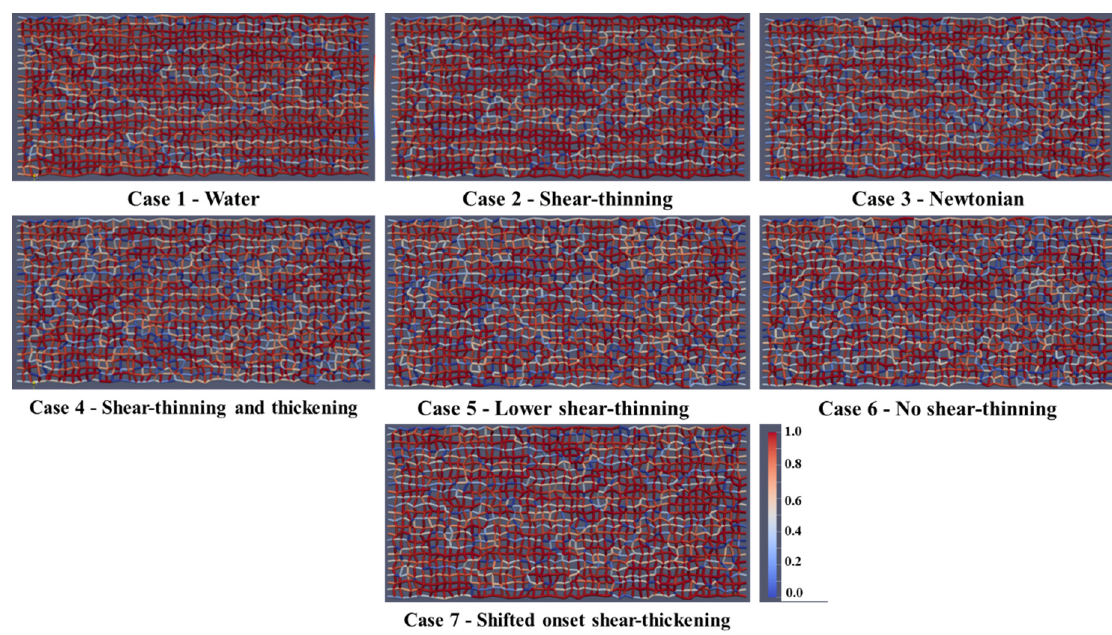
Figure 8. Fluid distribution (oil and water) after 1.0 PV of injected fluid.